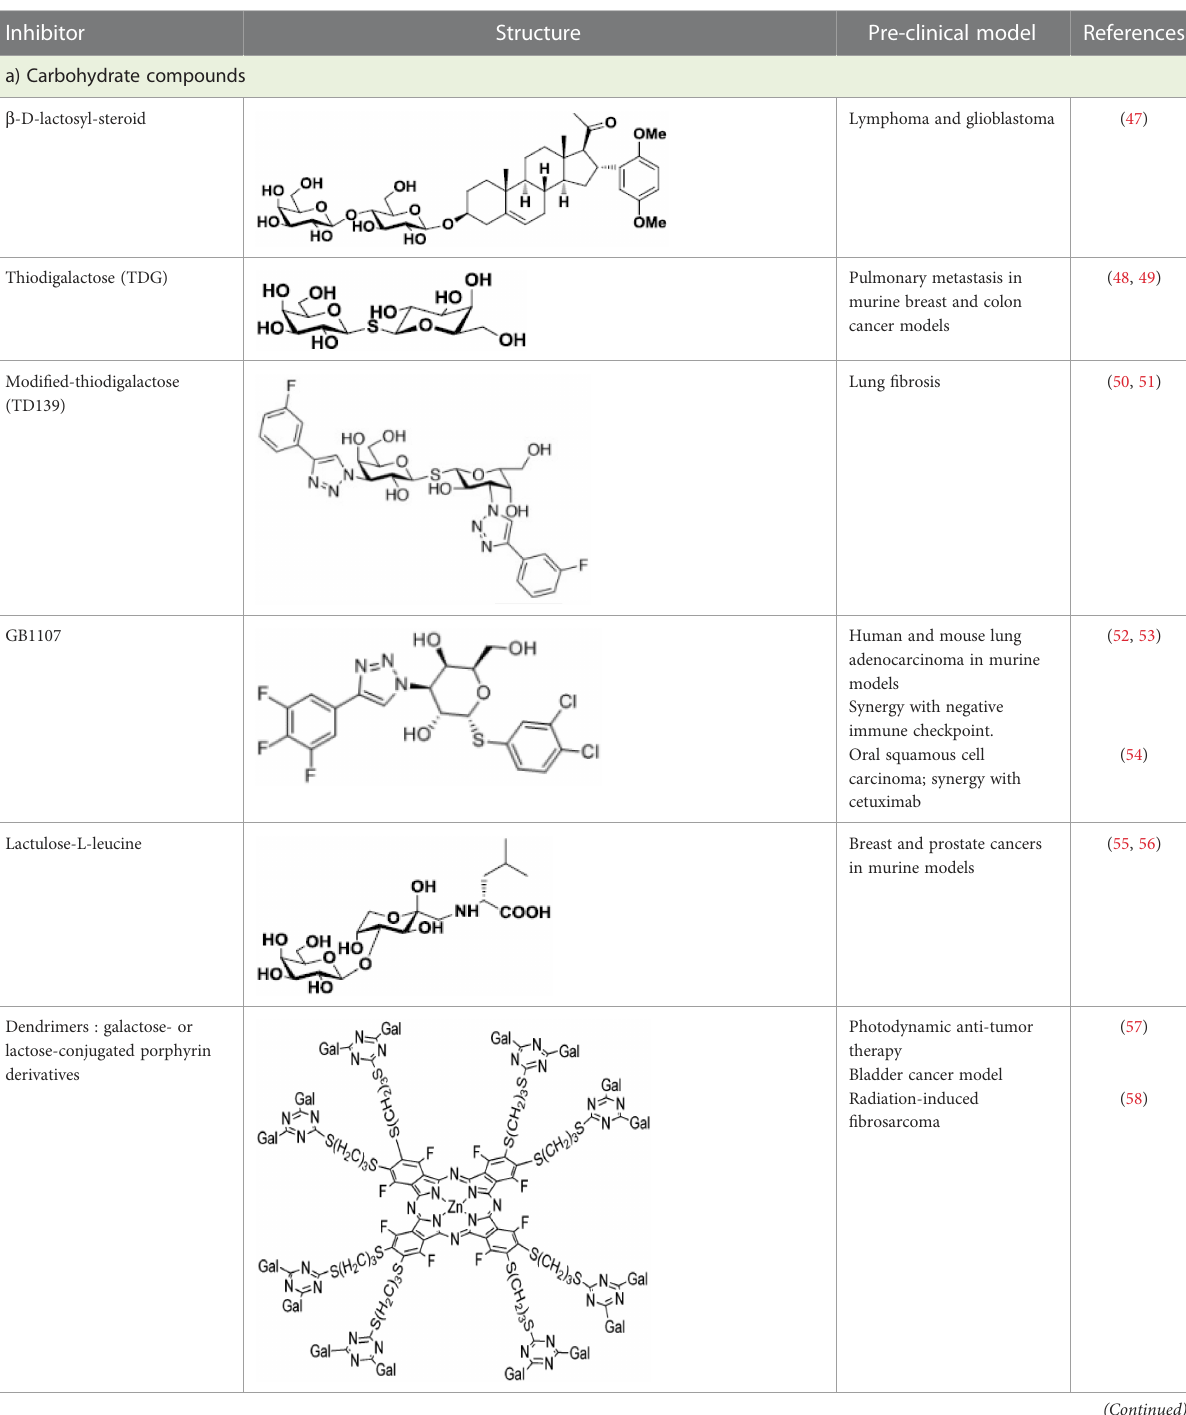
TABLE 1 In vivo pre-clinical studies with galectin